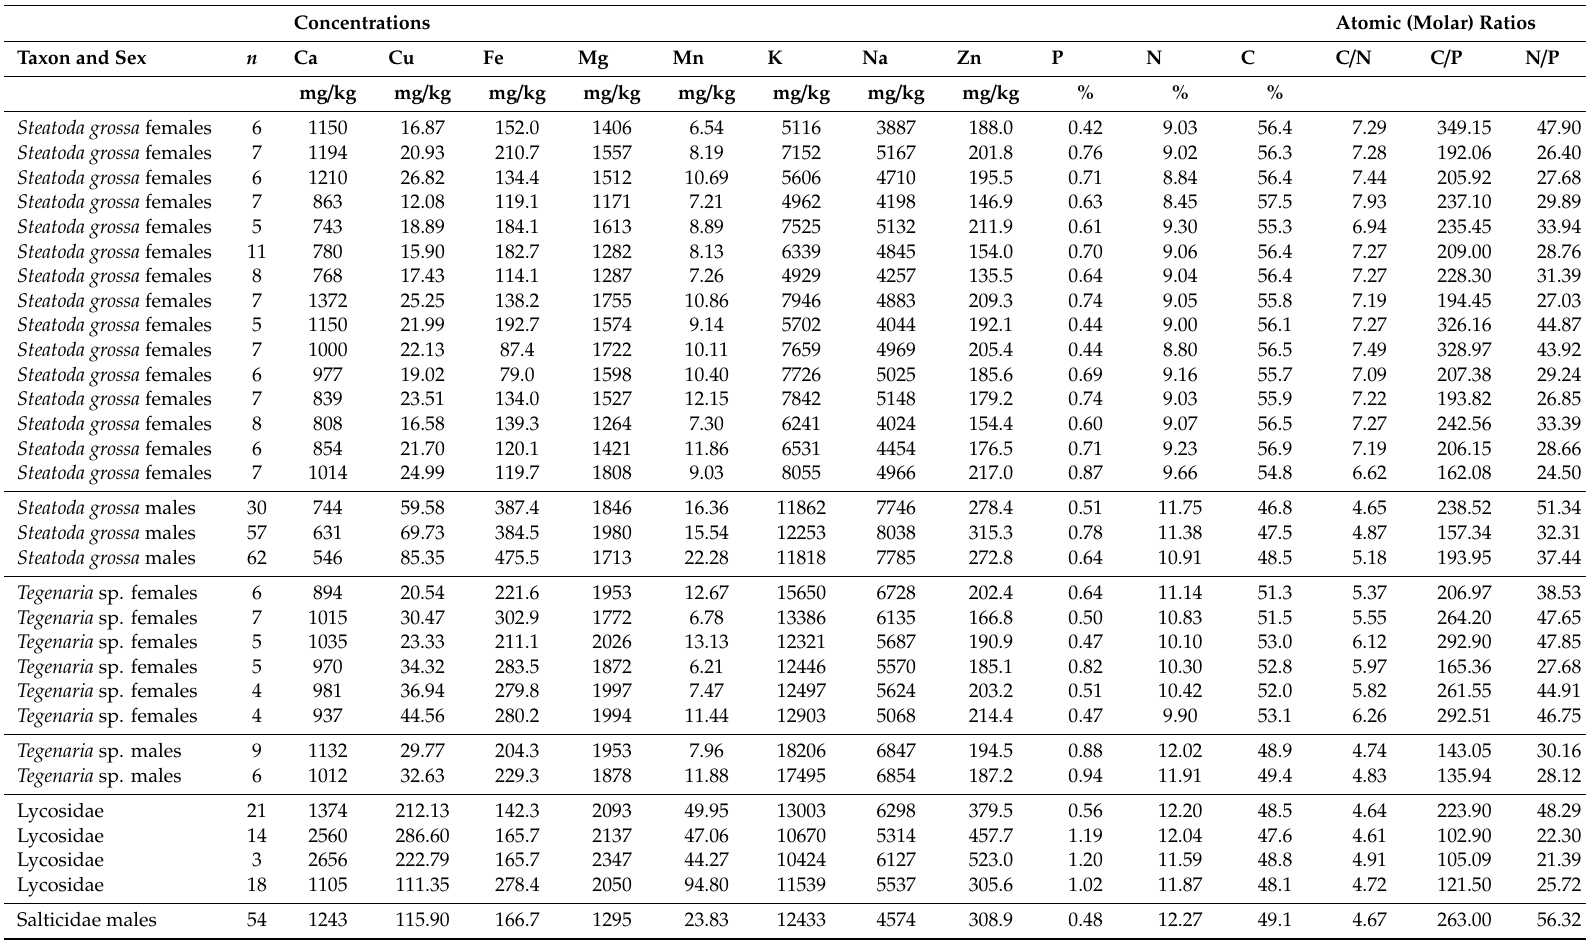
Table A1. Concentrations and C : N : P molar ratios for all six species of spiders with di ff erent hunting strategies. All raw data were collected; n = number of individuals per analytical sample. See the Table S1 for a user-friendly Excel